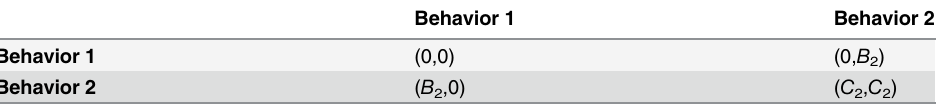
Table 3. The Payoff Matrix of the Interactions in Small Group 2(Simplified Form).